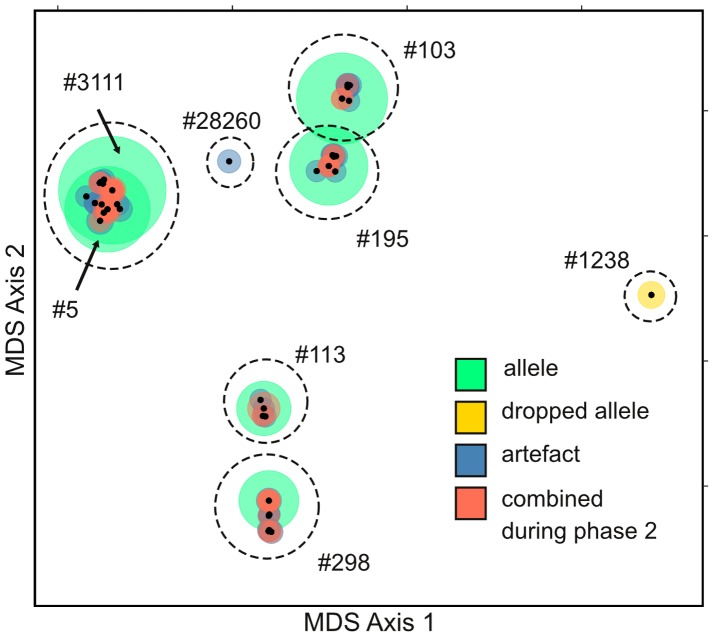
MDS plot of sequences in sample library X.Small black dots indicate the 101unique sequences present in the sample library. Sequences have been plotted on the first two MDS axes generated using the same similarity matrix used during clustering, such that more similar sequences are closer together. The color of the larger circles indicates the final status of each sequence, whereas the size of each circle is proportional to the number of reads in the sample library that match that sequence (see Table S3 for list of sequences and their respective read numbers). Sequences indicated in red were combined with other more frequent sequences during phase 2. Sequences indicated in blue were deemed to be artifactual sequences. Allele #1238 (yellow) was not considered a good cluster in phase 3 (too small) but was considered a true allele after cross-checking in phase 4. The green circles indicate sequences corresponding to the other 6 true alleles. The dotted lines indicate the seven clusters (4 good, 1 ambiguous, 2 small) after the 97% similarity threshold had been reached in phase 3.